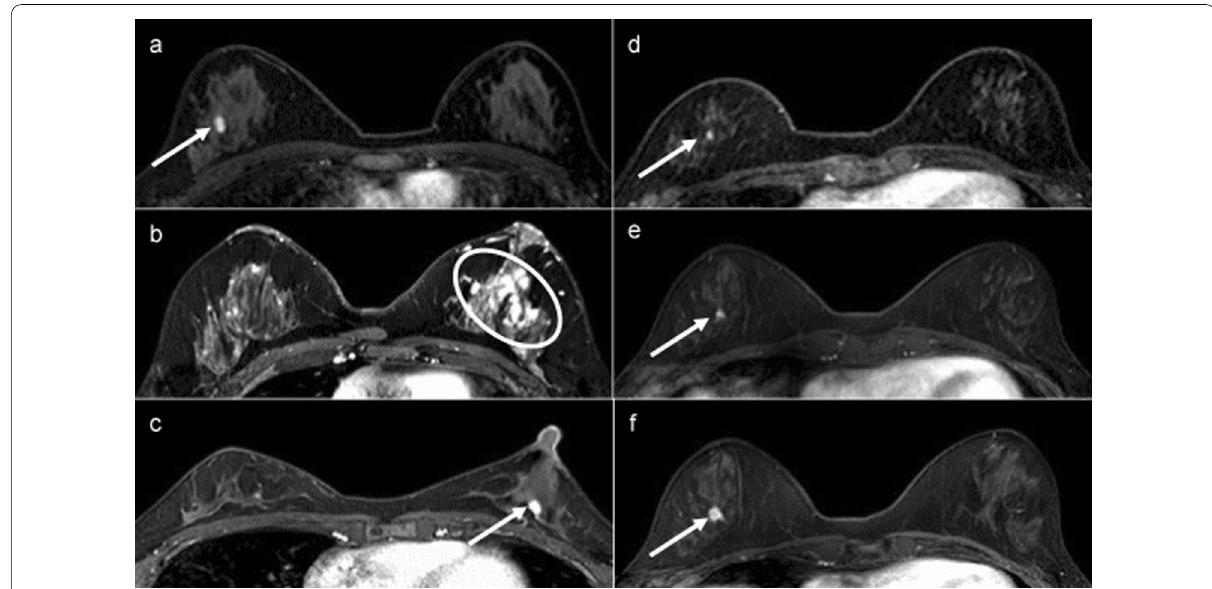
Fig. 1 Fat-suppressed post contrast T1-weighted image. a A 9-mm oval circumscribed mass (arrow of a ) on Case 1. b Segmental clumped non-mass enhancement (circle of b ) on Case 2. c A 6-mm round circumscribed mass on the chest wall side (arrow of c ) on Case 3. d A 3-mm enhanced nodule (focus) (arrow of d ) on Case 4. e Three months later from first screening MRI, no significant change (arrow of e ) on Case 4. f Nine months later from first screening MRI, the lesion was increased as a 10-mm not-circumscribed and heterogeneous enhanced mass (arrow of f ) on Case 4